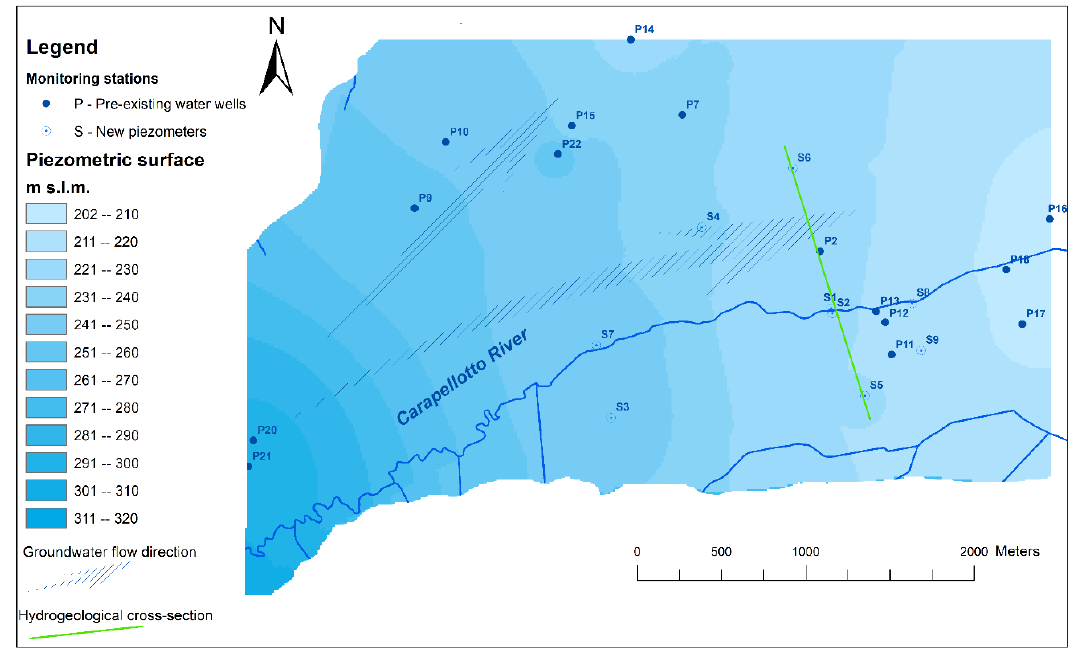
Figure 10. Piezometric map of the study